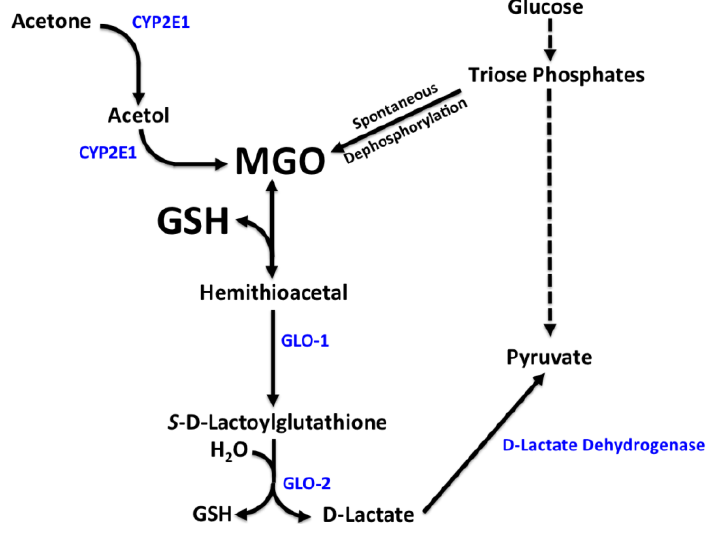
Figure 1. Major pathways of methylglyoxal (MGO) formation and detoxification. MGO in vivo is formed primarily from two pathways [2,24]. (Upper Right) triose phosphates derived from glycolysis spontaneously dephosphorylate to form MGO. (Upper Left) Acetone derived from ketogenesis is successively converted by cytochrome P450 2E1 (CYP2E1) to acetol and then to MGO. MGO detoxification (bottom left) occurs through the glutathione (GSH)-dependent glyoxalase (GLO) pathway [2]. MGO and GSH spontaneously form a hemithioacetal adduct that is successively detoxified by GLO-1 and GLO-2 to D -lactate, which is then converted to pyruvate by D -lactate